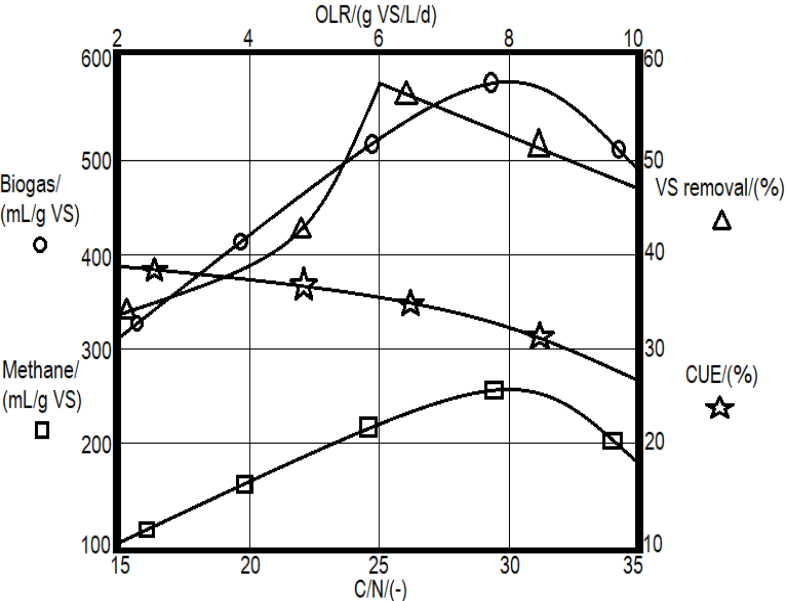
Figure 3. Application of the concept of CUE from soil science to the AD process. The relation between the CUE and the C/N for terrestrial decomposers was taken from the Figure 1a of Sinsabaugh et al. [53]. Reproduced with the permission of Ecology Letters (John Wiley & Sons). The relation between the biogas yield, the methane yield, and the vs. removal with the C/N for the operation of a discontinuous reactor was taken from Figure 3 of Wang et al. [58], who carried out 30-day AD experiments with a S/I of 0.5 (expressed in terms of VS). Reproduced with the permission of Bioresource Technology (Elsevier).